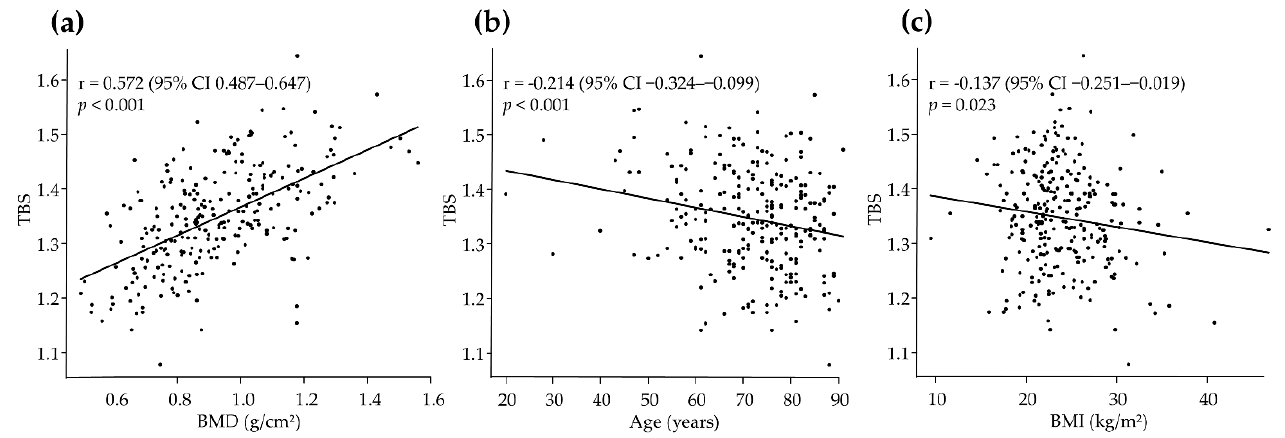
Figure 1. Correlation coefficient between TBS and ( a ) BMD, ( b ) age, and ( c ) BMI. The correlation coefficient between TBS and BMD is positive (r = 0.572, p < 0.001), whereas the correlation is negative for age (r = − 0.214, p < 0.001) and BMI (r = − 0.137, p = 0.023). The correlation between TBS and the variables of interest is analyzed using the Pearson correlation coefficient. BMD, bone mineral density; BMI, body mass index;